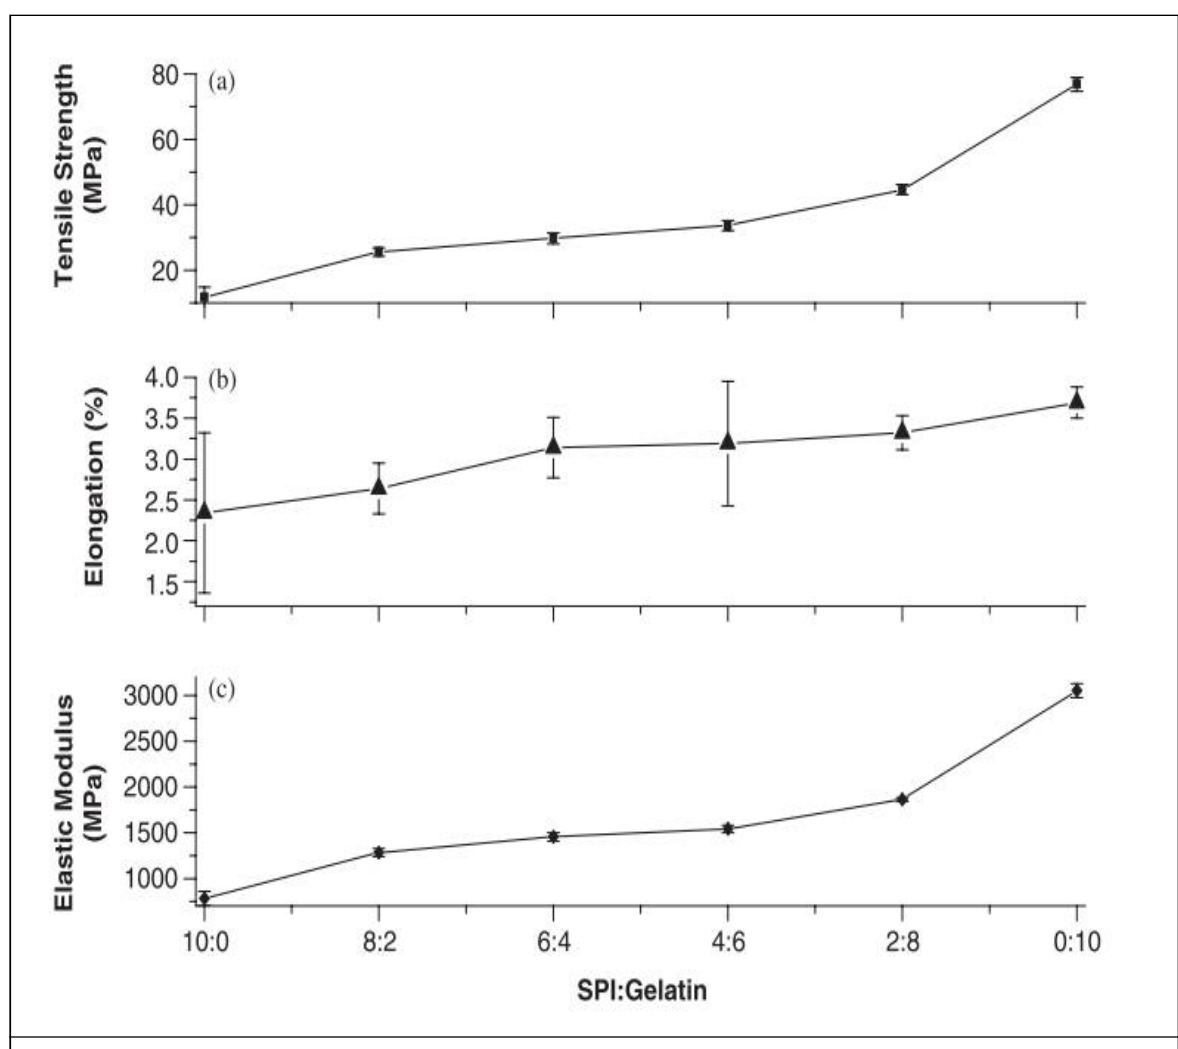
Figure 9: Tensile strength (a), elongation to break (b), and elastic modulus (c) of composite films prepared with different radius of SPI/gelatin ratios (containing 0.1 g glycerin/g